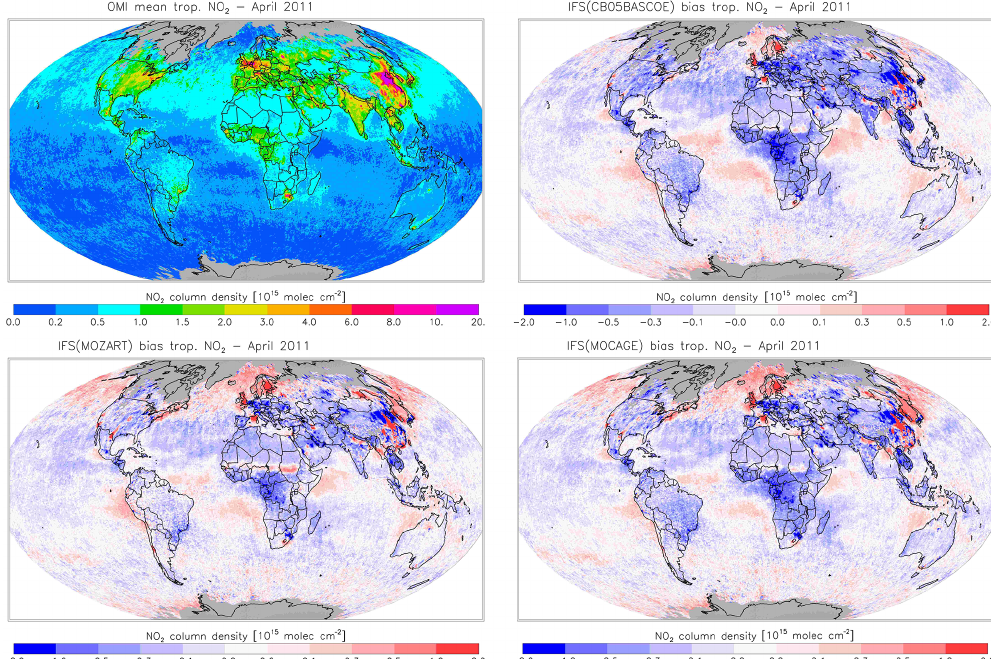
Figure 18. Monthly mean tropospheric NO 2 columns from OMI satellite retrievals from the QA4ECV product for April 2011, along with the corresponding collocated model